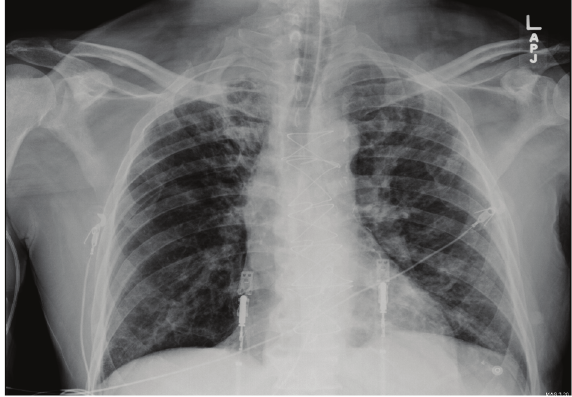
Figure 1: Preoperative chest X-Ray (CXR).